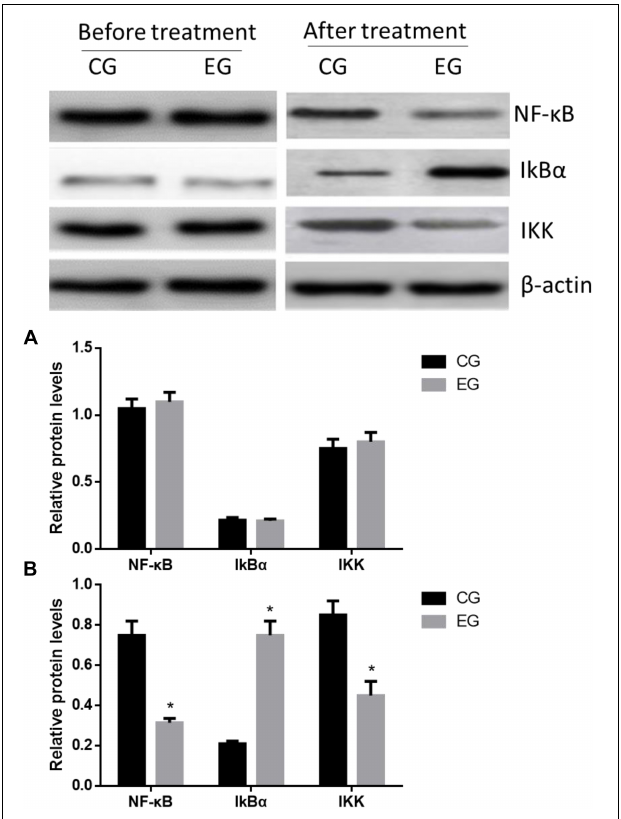
FIGURE 3 | Western Blot analysis of relative protein levels between two groups. (A) Before treatment. (B) After treatment. ∗ p < 0.05 vs. the CG group.